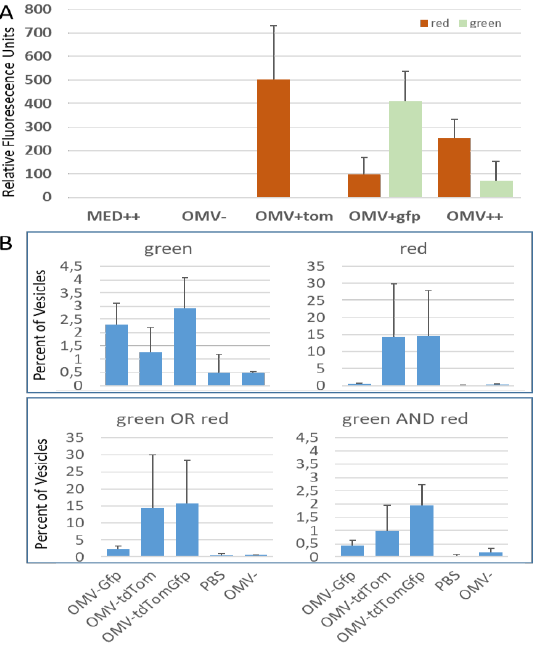
Figure 6. Double painting—overview of fluorescence and nanovariant flow cytometry data. ( A ) Samples after double painting were analyzed in a plate reader for fluorescence. While no fluorescence above background was detected in samples either containing no OMVs (MED++) or no GPI proteins (OMV − ), red fluorescence only was observed in OMV only treated with tdTomato (OMV + tom). Significant GFP fluorescence was observed in OMV + gfp sample accompanied by a low level of red fluorescence. When both fluorophores are present (OMV++), both channels show fluorescence, but at reduced levels. ( B ) The nvFC analysis of double painting. Again, samples containing no vesicles or no OMVs show few positive events (see PBS and OMV- samples in all four graphs). OMVs carrying a green fluorescence (top left panel) are found in the samples OMV-Gfp and the double-stained OMV-tdTomGfp. GFP-positive vesicles are also observed in the OMV-tdTom sample, most likely due to the stronger fluorogenic properties of tdTomato. Red fluorescence (top right panel) is observed in the OMV-tdTom and the double-stained OMVs. The bottom left figure depicts all fluorescent vesicles (combining double- and single-labelled vesicles). The bottom right graph shows vesicles containing both, red and green fluorescence in a single vesicle. This information would not be available from fluorometry data alone. All error bars indicate standard deviations. N =